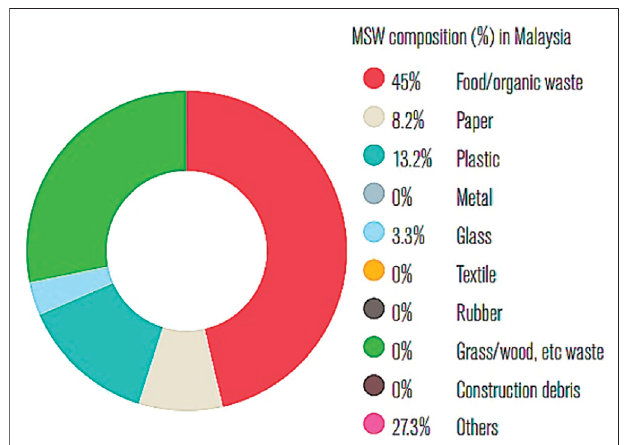
FIGURE 3 | Composition of MSW in Malaysia as per the United Nation environment report